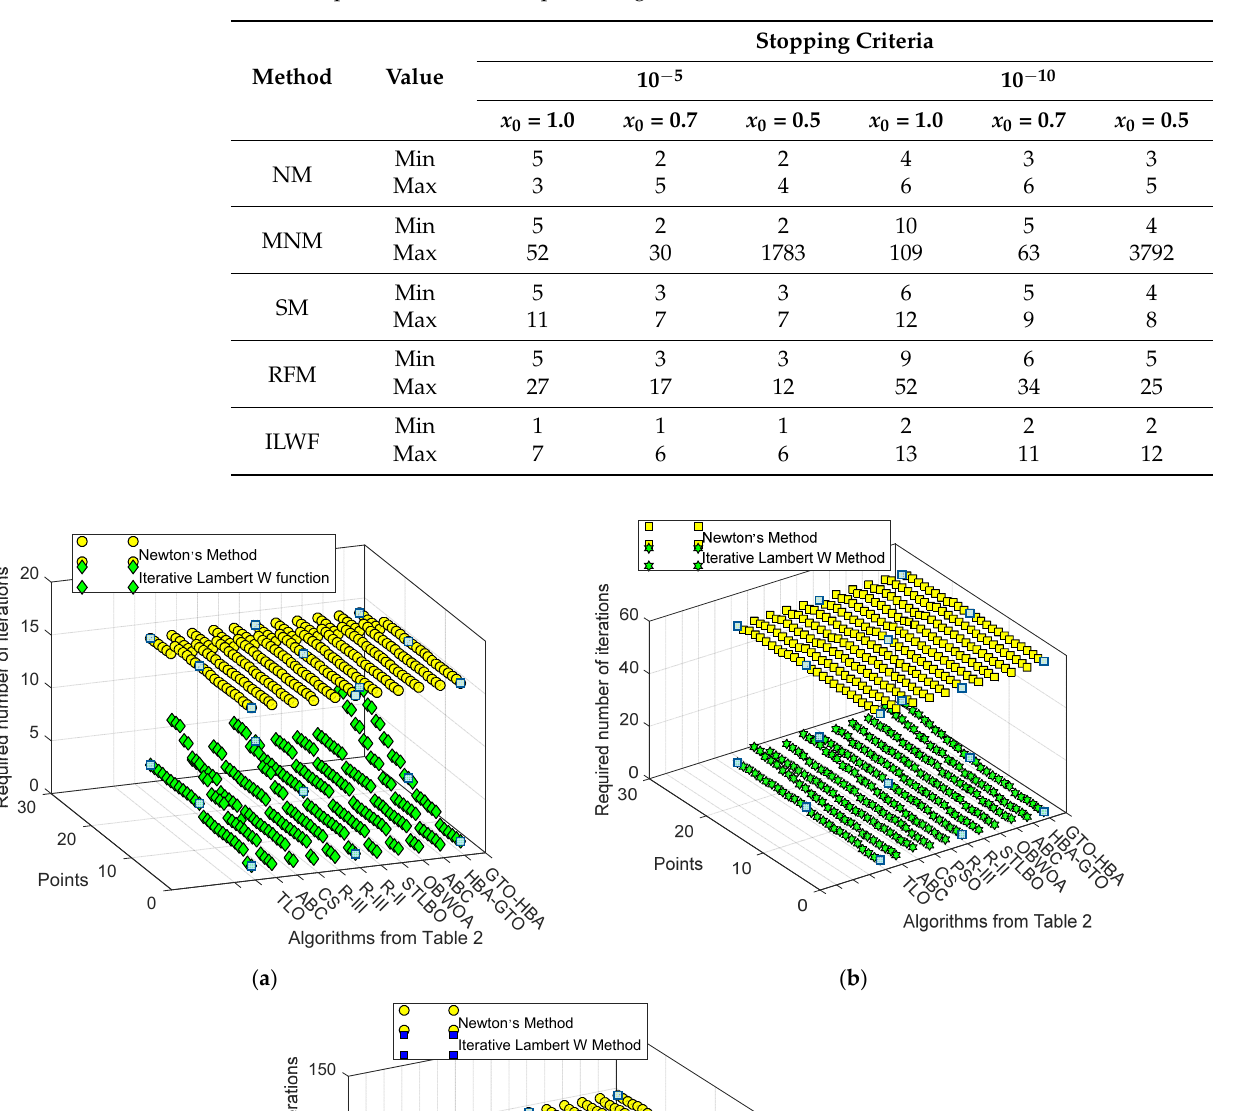
Algorithms from Table